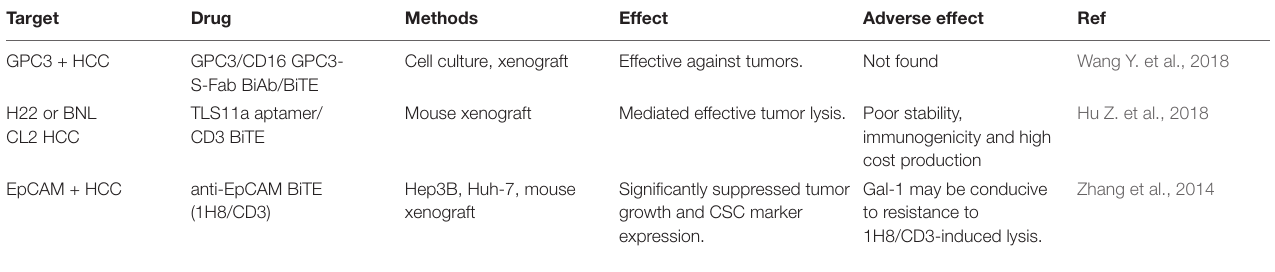
TABLE 2 | BiAb-based immunotherapy against the tumor associated antigens of HCC.